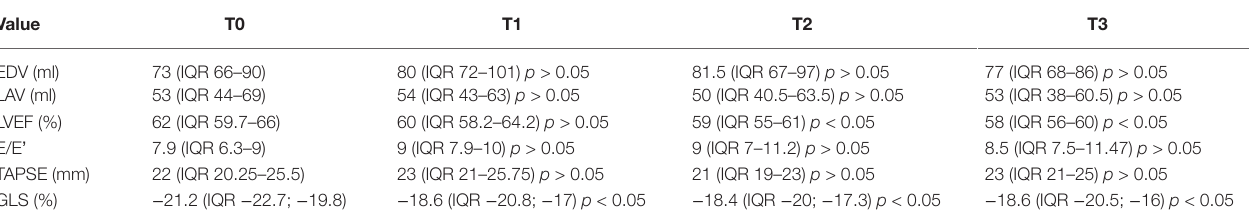
TABLE 3 | Multiple comparisons of echocardiographic parameters at different time of evaluation according to Friedman test (value of p refers to the changes that occur in the various times compared to the baseline).